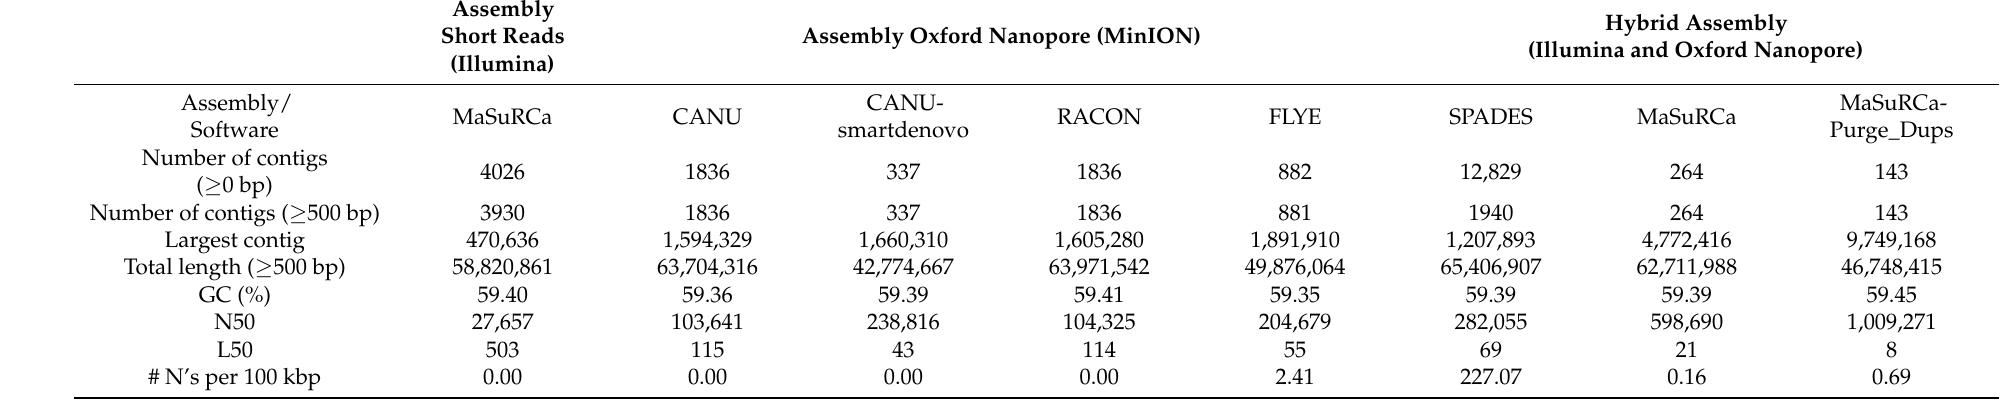
Table 2. Summary statistics for the assembled genomes of Trametes villosa CCMB561 using reads from Illumina HiSeq and Oxford Nanopore